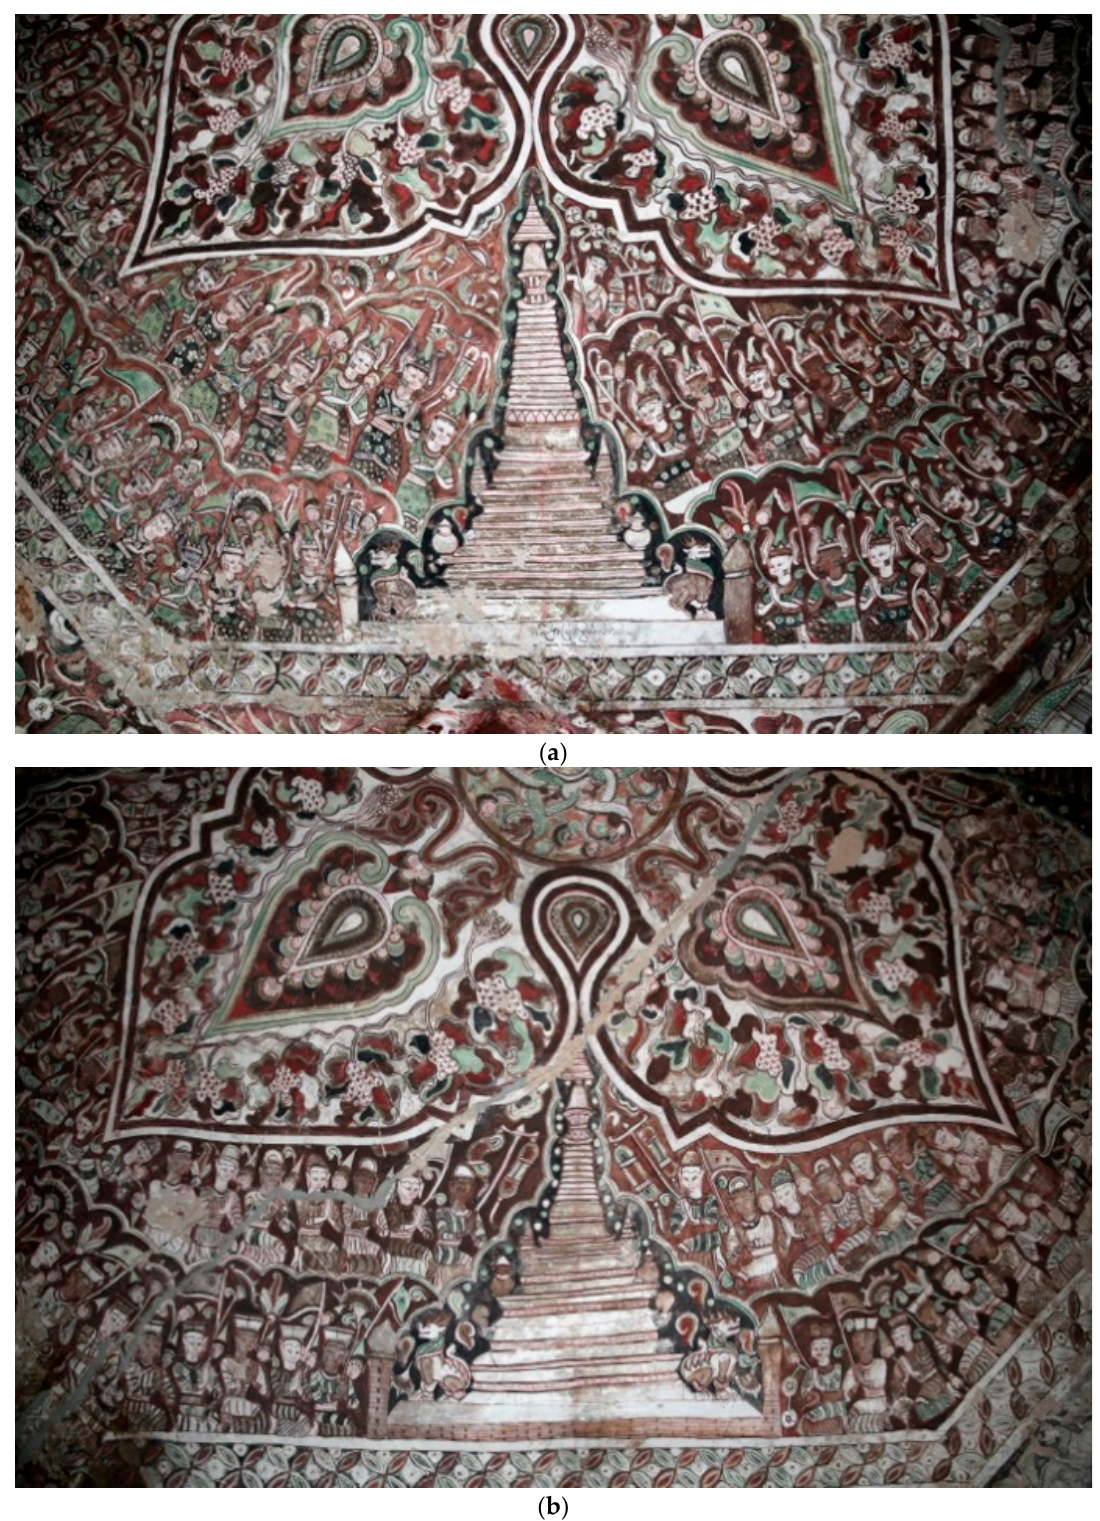
Figure 26. Powin Daung, late 18th century, cave 284. Two tooth relics. ( a ) shows tooth relic being revered in Tavatimsa by Indra, a tiny Shin Malae holds the broom. ( b ) shows a tooth relic revered by the Chinese, as interpreted in a late 18th century version.